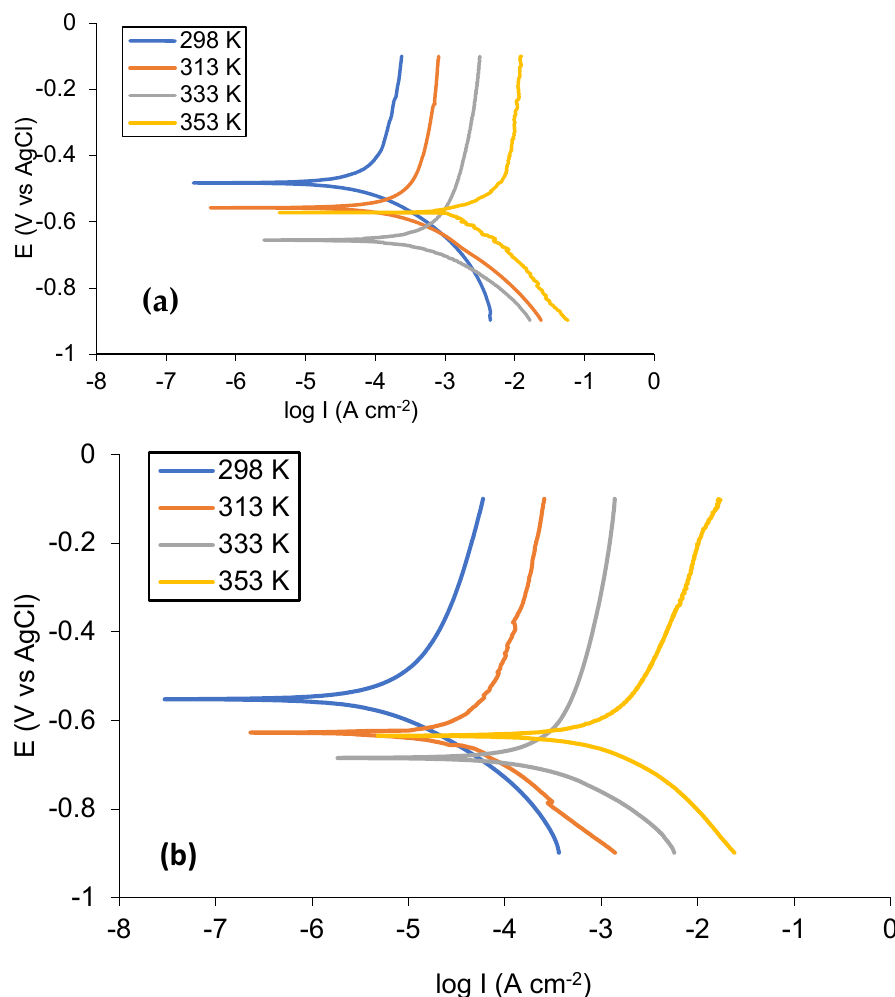
Figure 2. Graph of potentiodynamic polarization for AA5052 uncoated ( a ) and coated chitosan for